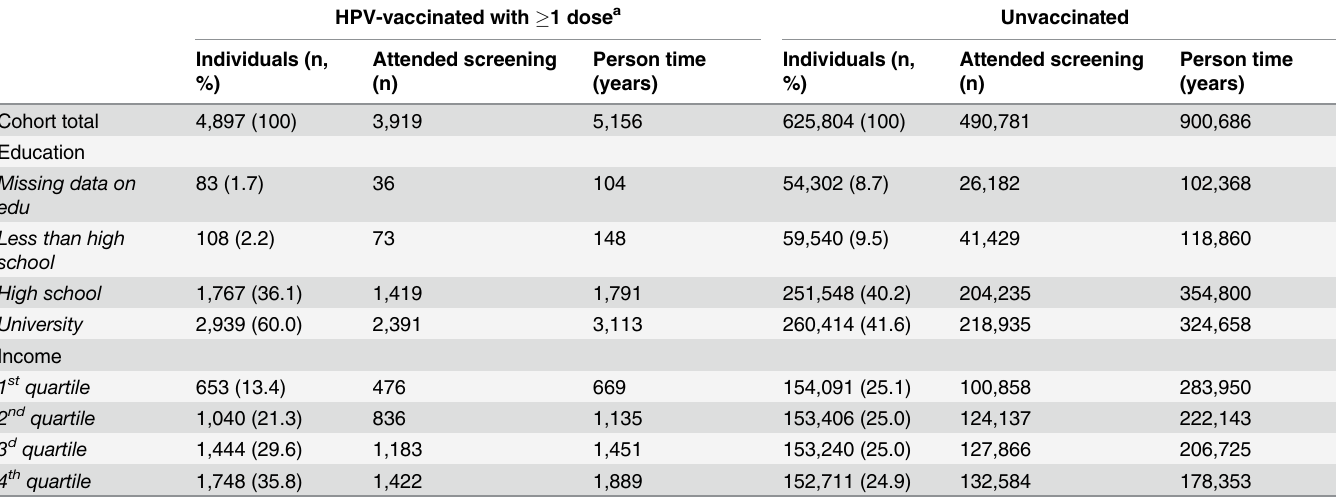
Table 1. Number of individuals, events, and person time by HPV vaccination status in the entire cohort and per education and income level. HPV-vaccinated with (cid:1) 1 dose